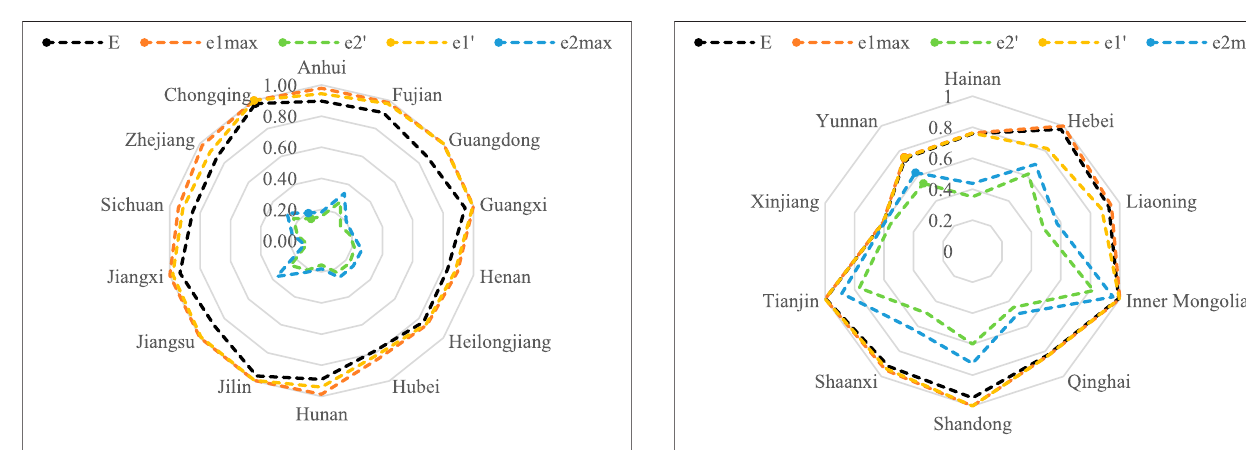
FIGURE 3 | Water – energy nexus system ef fi ciency. IP and WT sub- ef fi ciencies in 10 provinces.